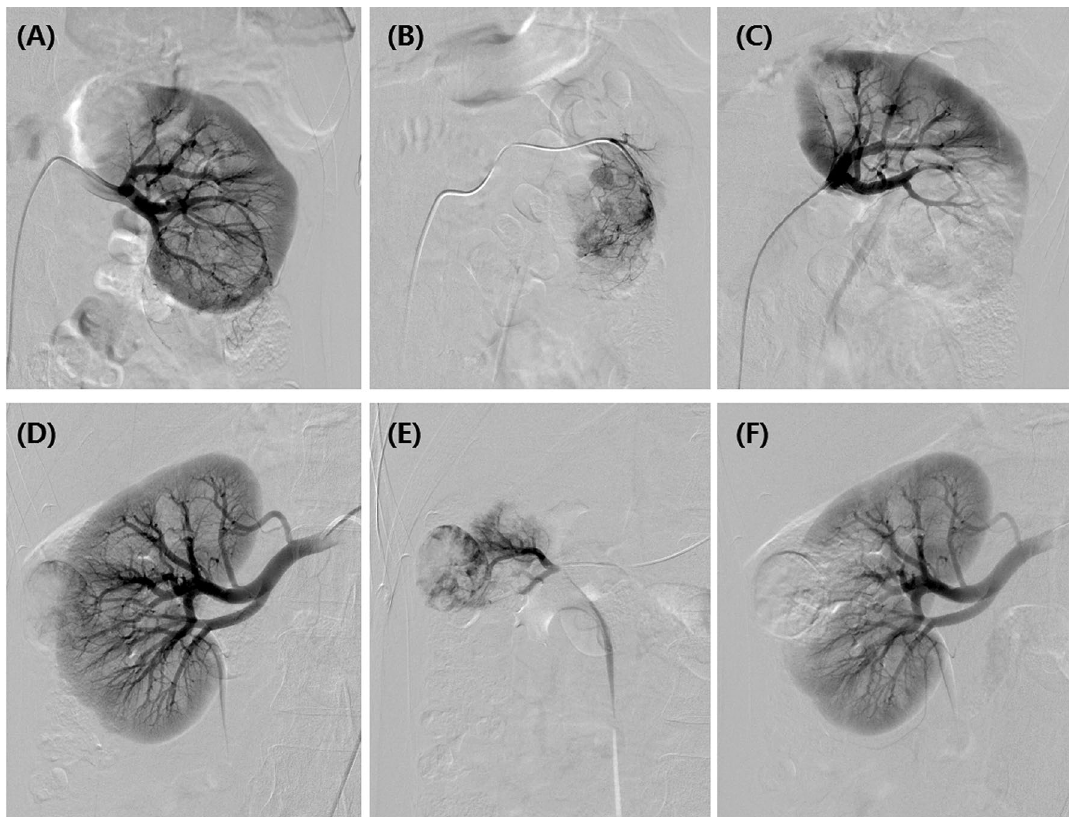
Figure 3. DEB-TACE for the female patients with bilateral RCCs. ( A ) A moderated RCC was shown in left kidney by renal artery angiography. ( B ) The tumor-feeding artery was superselectively incubated via microcatheter. ( C ) The blood supply artery was embolized by the drug-loaded microspheres. ( D ) A small RCC was shown in right kidney by renal artery angiography. ( E ) The tumor-feeding artery was superselectively incubated via microcatheter. ( F ) The blood supply artery was embolized by the drug-loaded